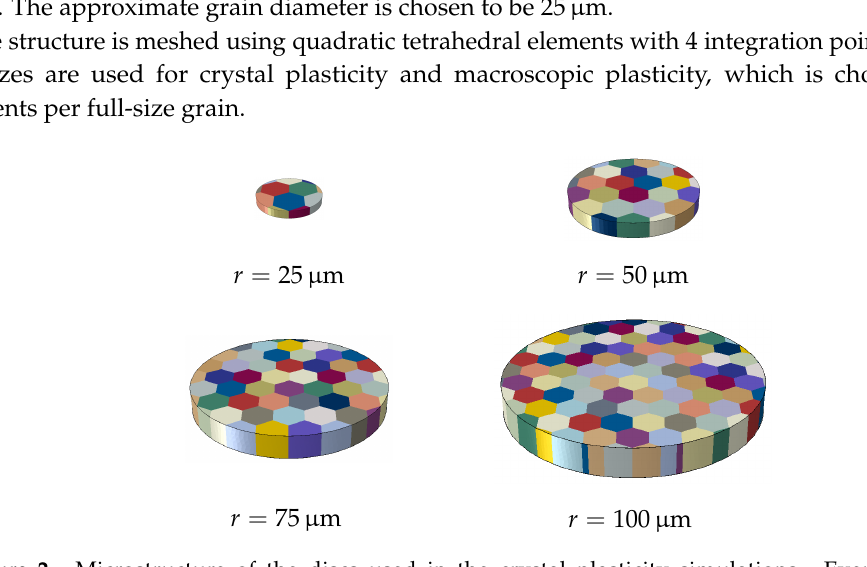
Figure 2. Microstructure of the discs used in the crystal plasticity simulations. Every crystal (represented by a different color) has a different crystallographic orientation.